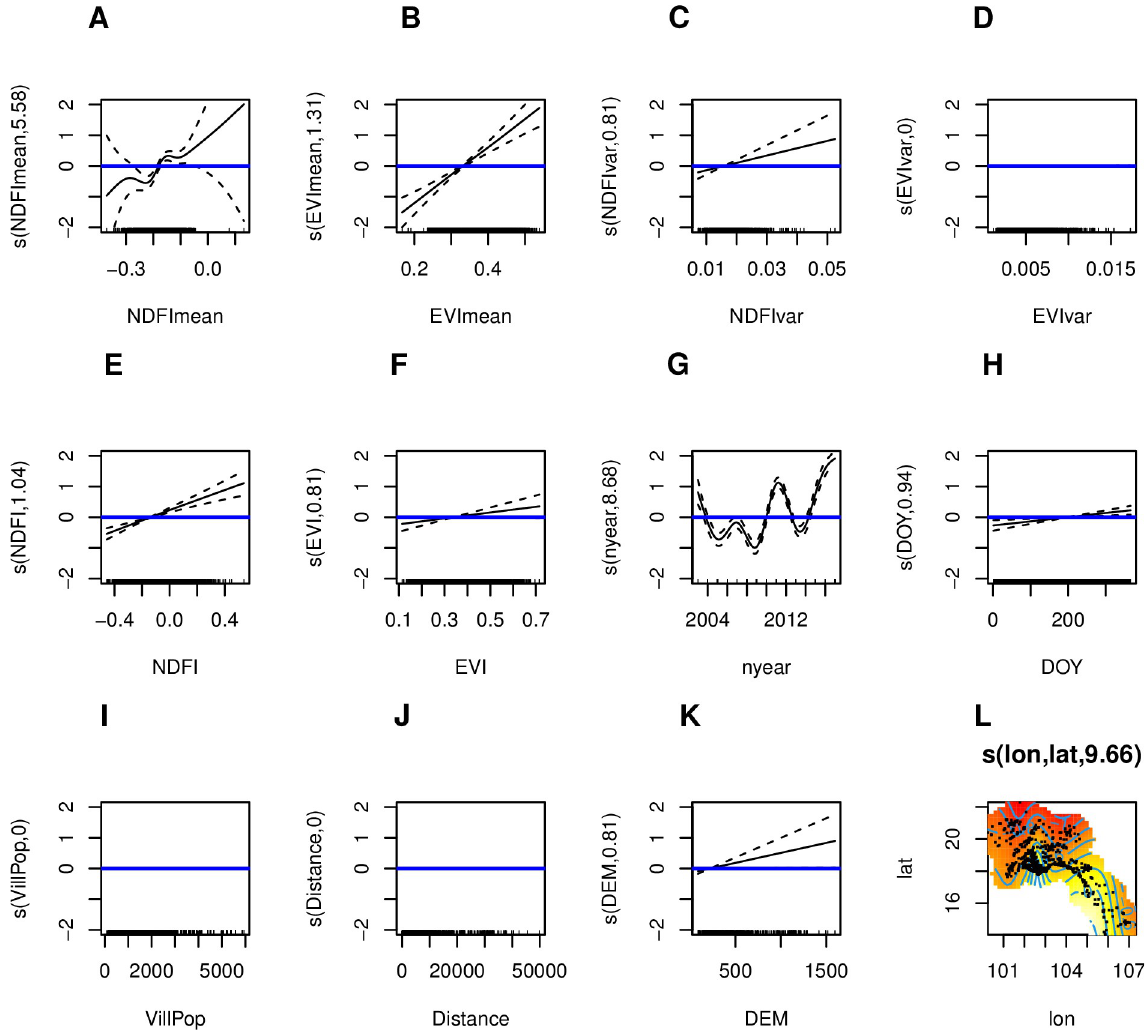
Fig 7. Results from generalized additive logistic regression for the geographic, demographic and environmental predictors of scrub typhus infection. A.) mean NDFI (normalized difference flooding index) for patient home village across study period; B.) mean EVI (enhanced vegetation index) for patient home village across study period; C.) variance in NDFI for patient home village across study period; D.) variance in EVI for patient home village across study period; E.) NDFI around patient home village in 16 days leading up to hospital admission; F.) EVI around patient home village in 16 days leading up to hospital admission; G.) year of hospital admission; H.) day of year of hospital admission; I.) population of patient home village; J.) distance from patient home village to nearest major road; K.) elevation of patient home village; L.) geographic coordinates of patient home village. Plots above the blue line (at the y-intercept) indicate a positive association for a given covariate, for the given x-axis value. For the geographic coordinates (panel L), lighter colored areas on the map indicate places with higher baseline risk of being diagnosed with scrub typhus. P-values are indicated in S5